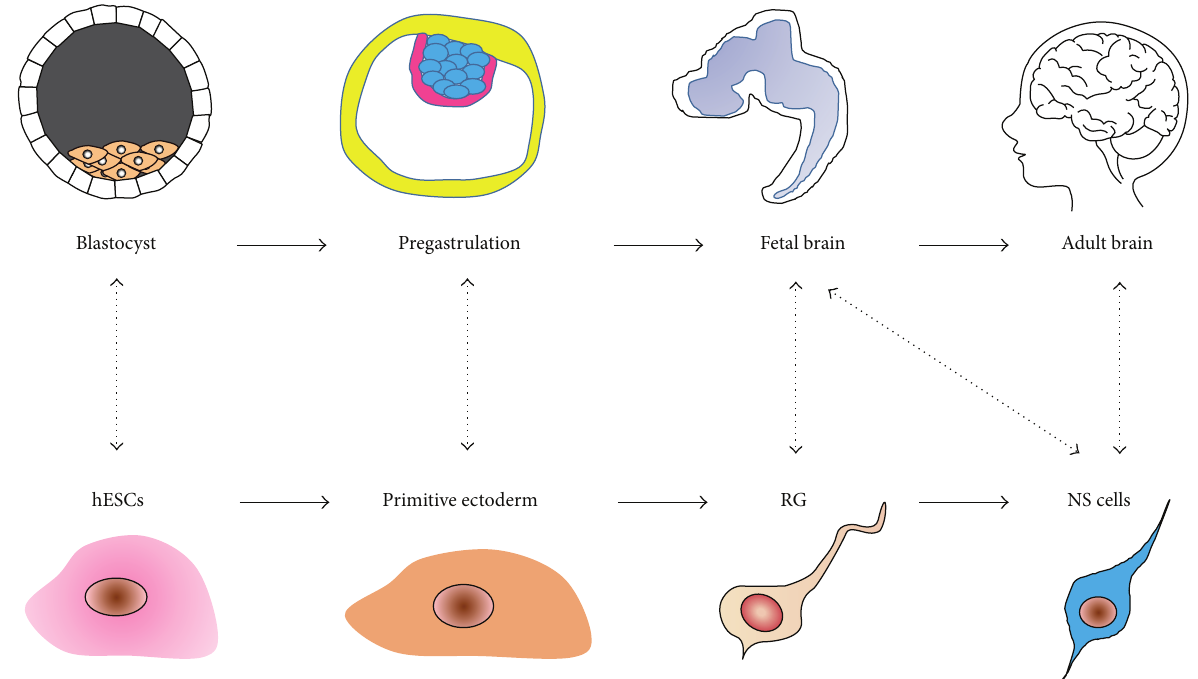
Figure 1: Developmental links between the different stages of neural derivatives of hESCs and their in vivo counterparts. Neural derivatives exhibit several similar characteristics to in vivo counterparts. The corresponding in vivo developmental stages are indicated and matched with the in vitro